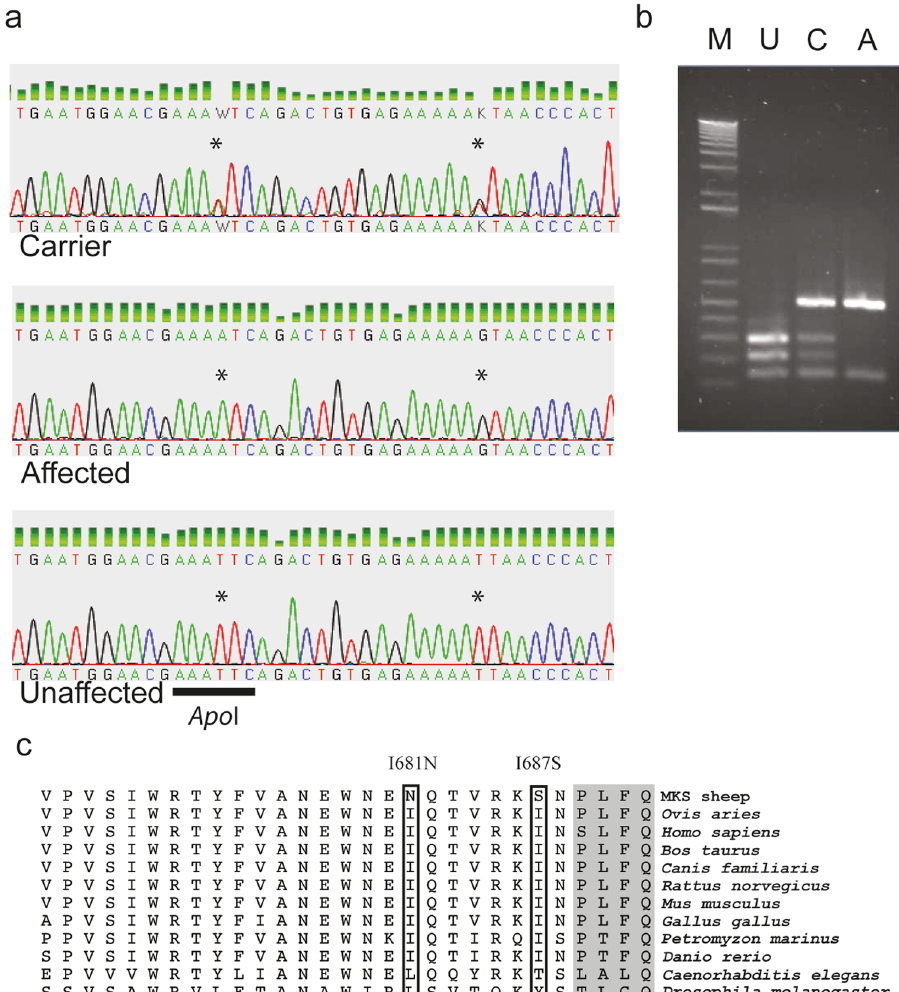
Figure 4. Identification of two missense mutations in TMEM67 . ( a ) Sequence analysis of TMEM67 showing sequence variants in exon 20 (indicated by asterisks above the sequence tracks) in a carrier, and in an affected lamb, compared to an unaffected lamb. Below the unaffected sequence, the Apo I restriction site is indicated (black bar) ( b ) Apo I restriction fragment length polymorphism generated by the sequence variants caused different restriction digestion patterns for the affected and carrier lambs, compared to unaffected lambs; M, marker; U, unaffected pattern; C, carrier pattern; A, affected pattern. ( c ) Alignment of mutant with wild type partial sequences of meckelin from multiple species. The diagram shows the isoleucine to asparagine amino acid substitution at position 681 (I681N), and isoleucine to serine substitution at position 687 (I687S) in an affected lamb (MKS sheep), compared to the unaffected ( Ovis aries ) meckelin sequence (boxed). The partial meckelin sequence is aligned with ten orthologous sequences from other species. The boxes show the affected amino acids, and conservation of an isoleucine amino acid at these positions in several vertebrate species, including humans and zebrafish. The amino acids in the grey portion mark the beginning of a transmembrane domain in